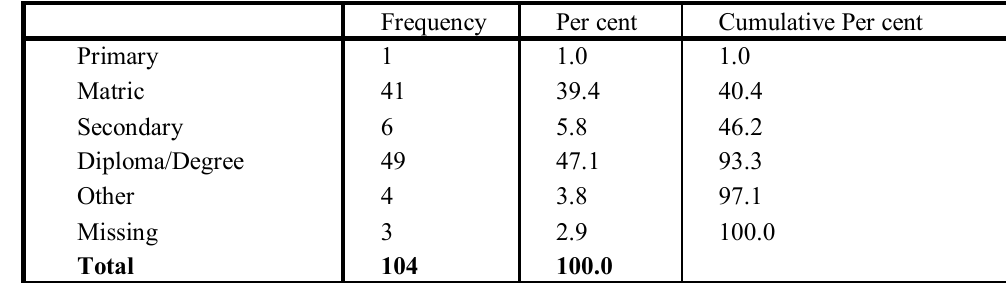
Table 3: Education level of respondents